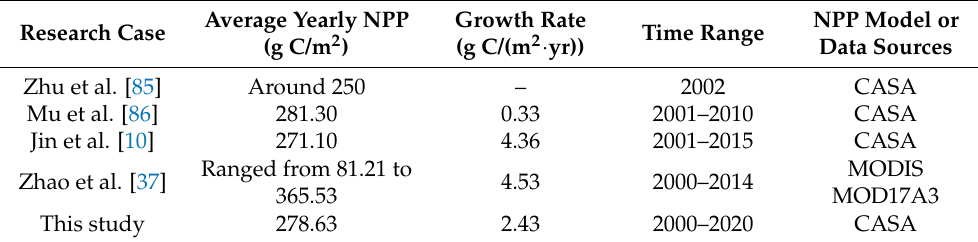
Table 7. Comparison with other NPP estimation